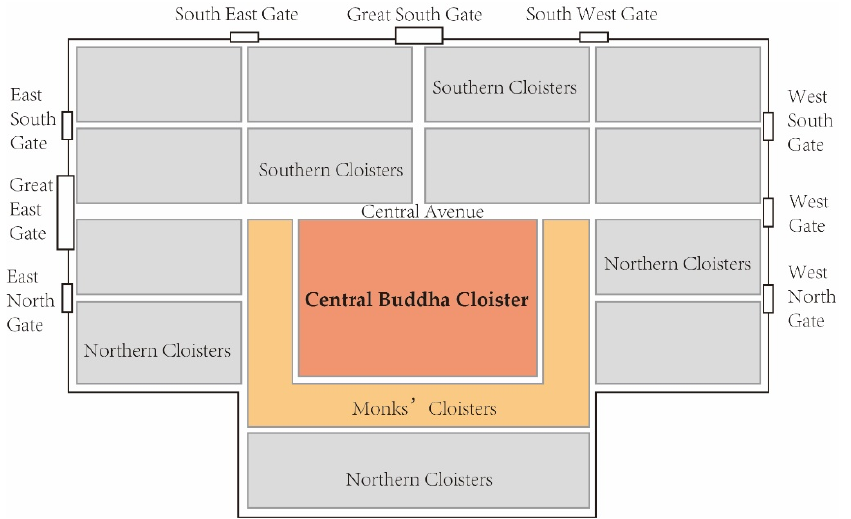
Figure 8. Schematic plan of Jetavana monastery based on Daoxuan’s description, reconstruction by Puay ‐ peng Ho (drawing by author, after Ho 1995, p. 6, Figure 2).